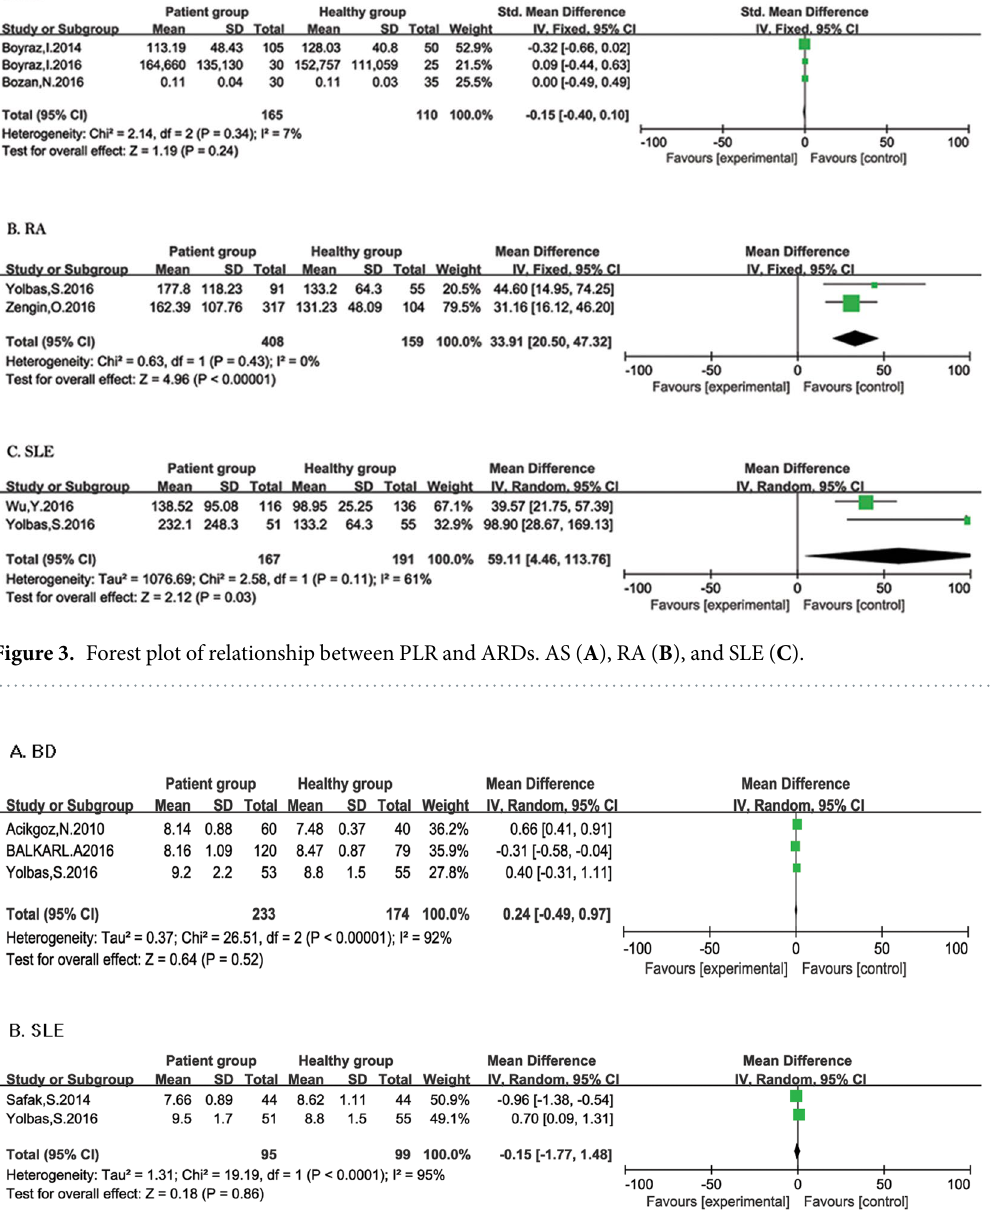
Figure 4. Forest plot of relationship between MPV and ARDs. BD ( A ), and SLE ( B ).